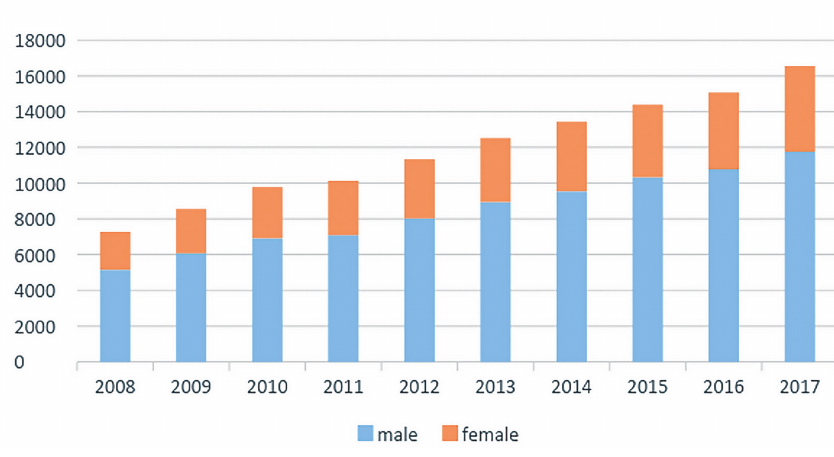
Figure 2 - Bladder Cancer admissions according to gender